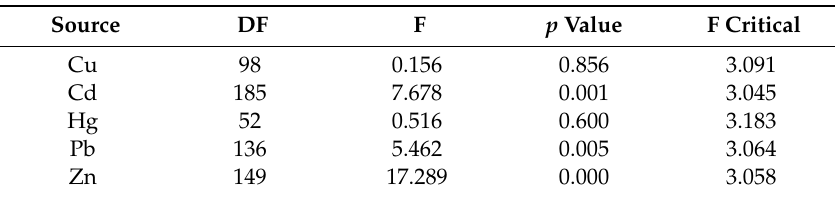
Table 2. ANOVA results for the Rock Creek, Hickey Run, and Watts Branch watersheds where DF is degrees of freedom and F is the F-statistic.